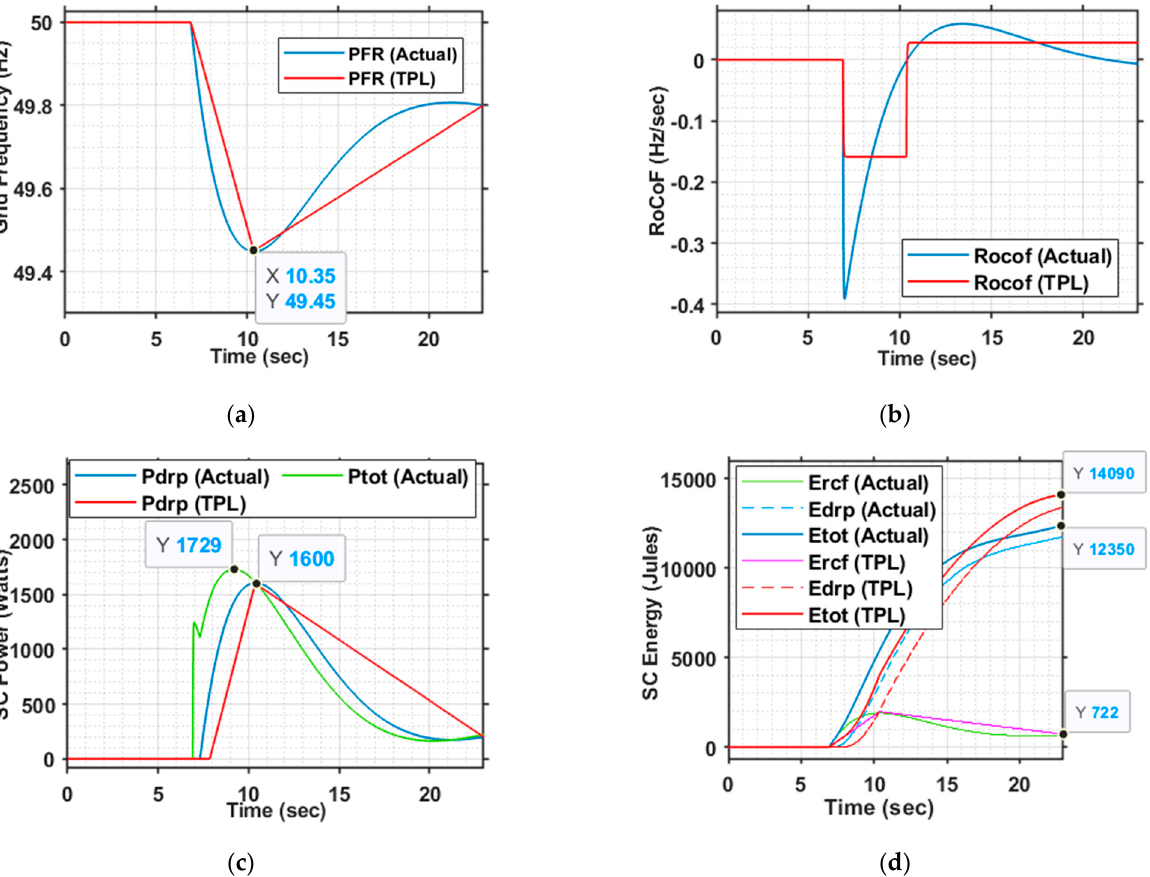
Figure 17. Verification of the proposed TPL-technique-based sizing methodology for PFR, in comparison with actual benchmark characteristics, using MATLAB simulation. The results shown for both cases are: ( a ) PFR characteristics indicating the frequency profile; ( b ) RoCoF subjected to variation in frequency; ( c ) estimated SC power with and without consideration of the effect of RoCoF; ( d ) estimated SC energy showing the energy corresponding to RoCoF, Droop control and the total energy, respectively.